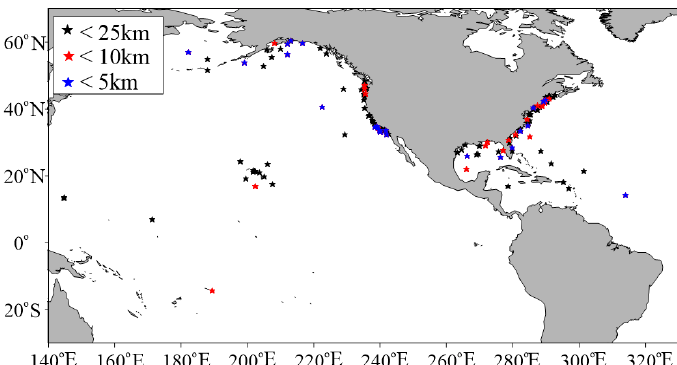
Figure 5. Location of the collocated NDBC buoys with Sentinel-3B.